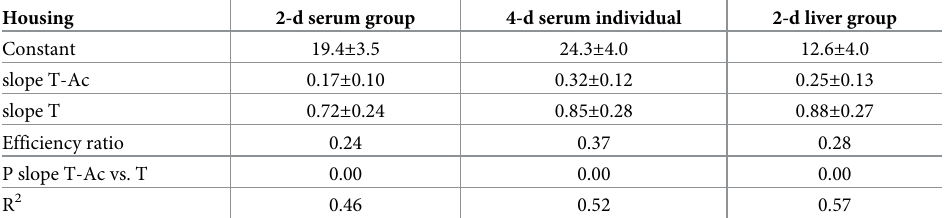
Table 4. Regression coefficients and efficiency ratio using linear models (serum data in μ M, liver data in μ g/g, die- tary levels in ppm; T-Ac = tocopheryl-acetate, T =